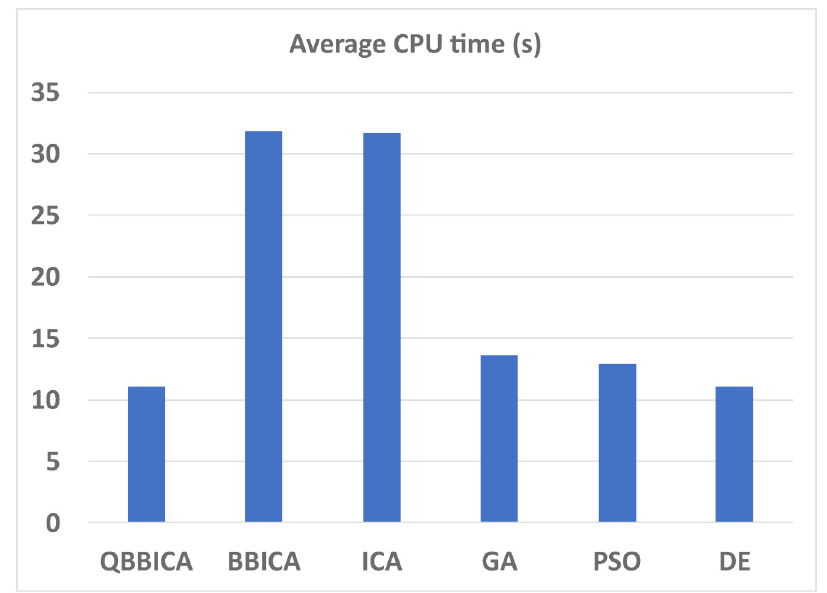
Fig 5. Average CPU time of QBBICA, BBICA, ICA, PSO, GA and DE in FCM training process.